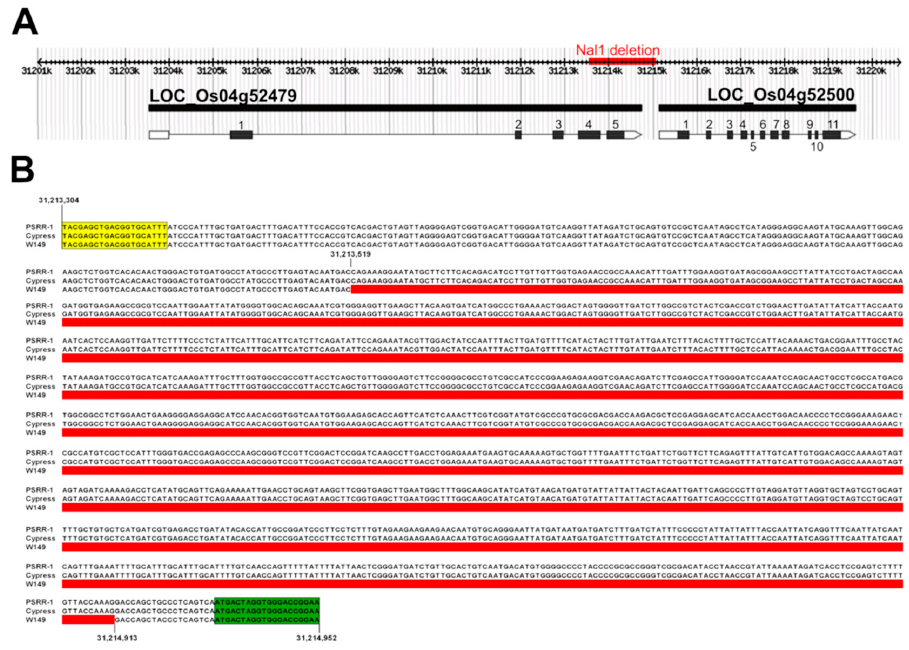
Figure 2. Location of the 1395-bp deletion in the nal1 locus (LOC_Os04g52479) in W149 genome. ( A ) The deletion encompasses a part of exon 4, exon 5, 3 ′ untranslated region (3`UTR), and downstream regions of LOC_Os04g52479, indicated by red bars. ( B ) Sequence alignment of PSRR-1, Cypress, and W149 Nal1 alleles containing the deletion (highlighted in thick red bar) with genomic coordinates 31,213,519-31,214,913 of chromosome 4. The deletion was verified by Sanger sequencing of PCR fragments. Forward and reverse primers are highlighted with yellow and green boxes, respectively.